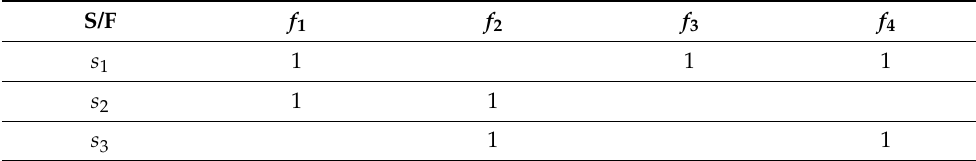
Table 1. Example of the FSM